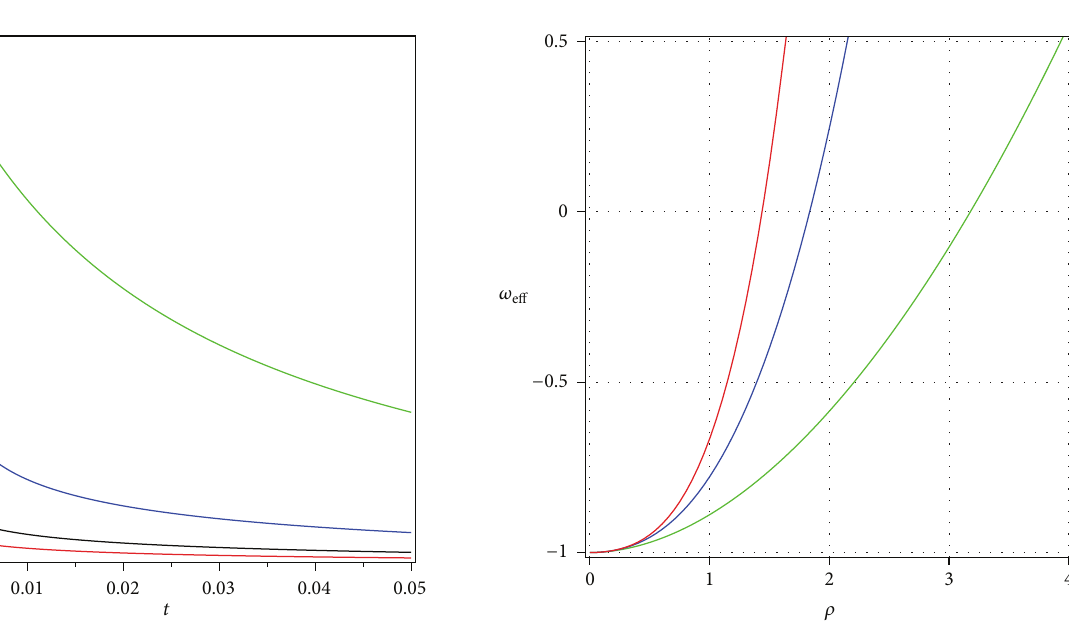
Figure 9: Hubble expansion parameter versus time for 𝐵 = 3 , 𝛼 = 0.9 and 𝐴 = 1/3 . 𝑛 = 1 (green line), 𝑛 = 2 (blue line), 𝑛 = 3 (black line), 𝑛 = 4 (red line).